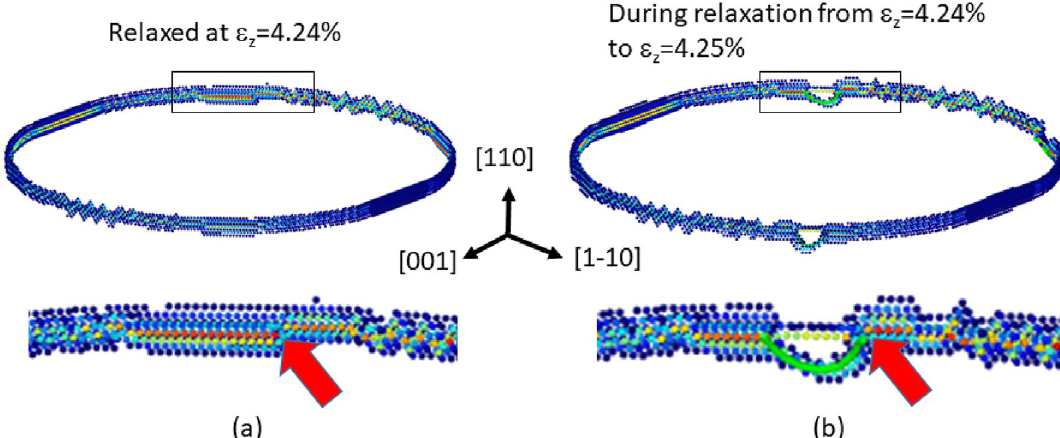
Figure 7. Tensile stress distributions before and after the dislocation (the green lines) emitted from the penny- shaped crack front along {110}: Only atoms with a relatively large σ zz are visible, and the color shifts towards red as σ zz increases, where the z direction is [110]. ( a ) The relaxed state at ε z = 4.24% ; ( b ) a snapshot in the course of relaxation from ε z = 4.24% to ε z = 4.25% . Each bottom diagram shows the magnified view in the area bounded by the rectangle of the upper